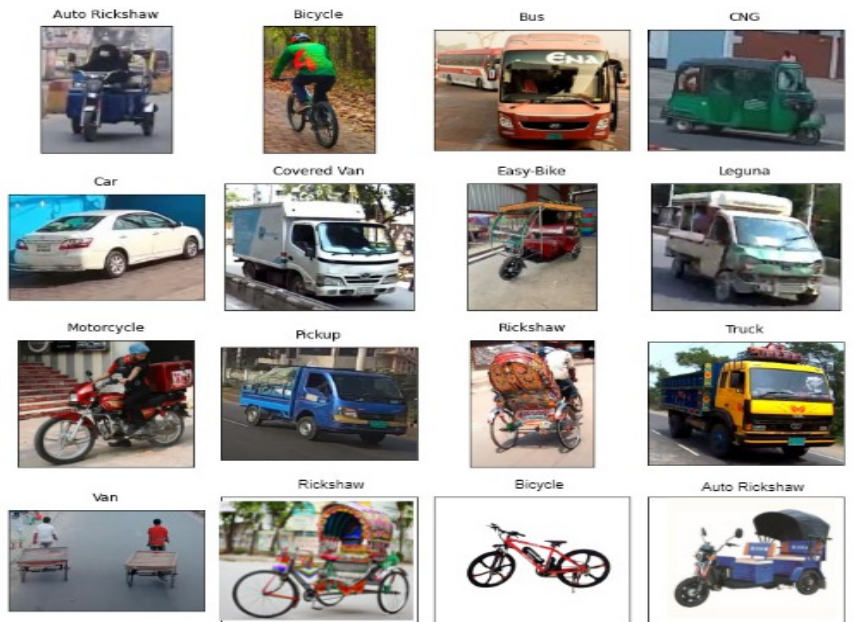
Figure 2. Sample Deshi-BD dataset images representing each class.